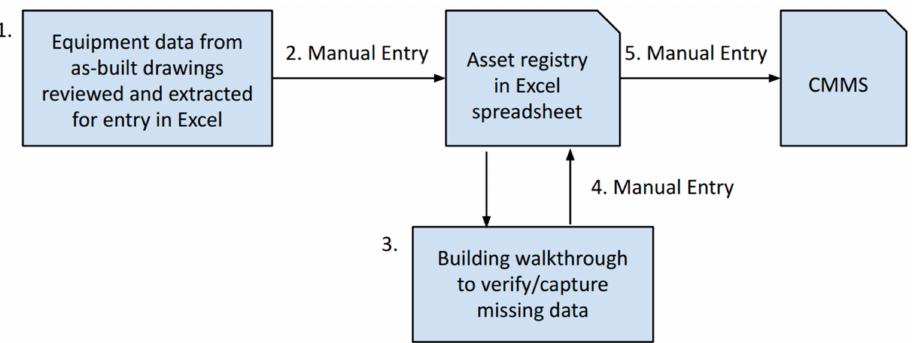
Figure 1. Conventional asset data collection (adapted from [45]). (1) Captured information is manually entered into an Excel spreadsheet. (2) Building walkthroughs are conducted to verify the data extracted from the as-built drawings. (3) Modifications are made to the Excel spreadsheet as needed. (4) Walkthroughs allow to verify and edit asset data, verify that equipment exists and is functional, and verify location of assets and location served by each asset. Images of assets are also captured for documentation purposes and entry into the CMMS. Once information collection is complete, it is manually re-entered into the CMMS